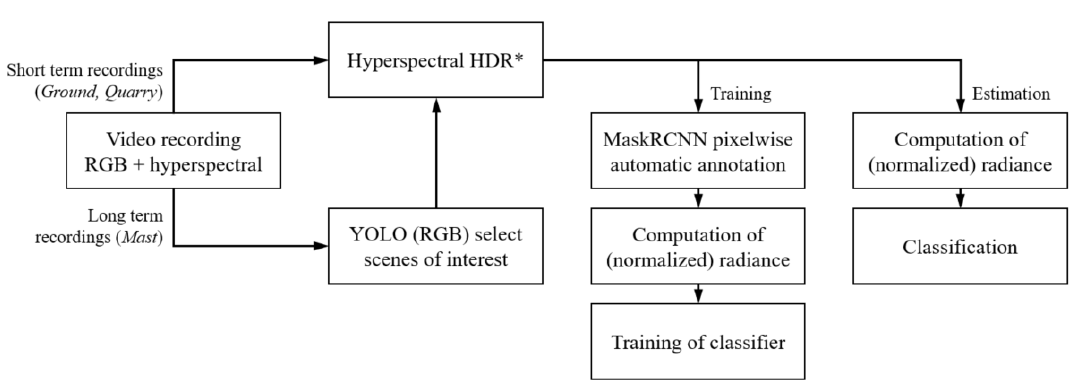
Figure 9. Main steps of the training and estimation workflows. * Hyperspectral HDR was only available for the Mast datasets. HDR = High Dynamic